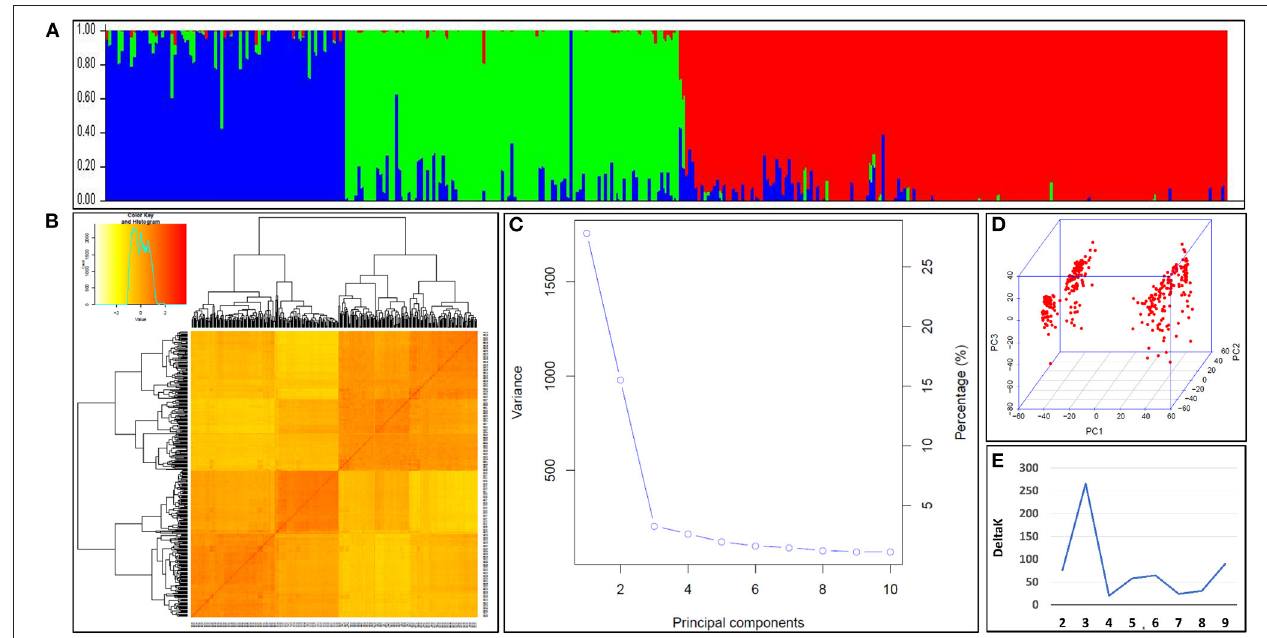
FIGURE 3 | (A) Population structure within the nested synthetic wheat introgression libraries. The population structure plots with each vertical bar representing a breeding line colored according to the particular group to which the breeding line has been assigned. The breeding lines assigned to more than one of group represents the degree of their admixed set of the alleles (B) The Kinship matrix displayed as the heat map, where the red indicates the highest correlation between the pairs of breeding lines and yellow indicates the lowest correlation (C) The Scree plot indicating the most of the variabilities explained by the first three principal components (PCs) for association study (D) The three-dimensional view of the PCs explaining the genotypic variation among breeding lines constituting the introgression libraries. (E) The appropriate number of the subpopulations determined from the largest delta, K =